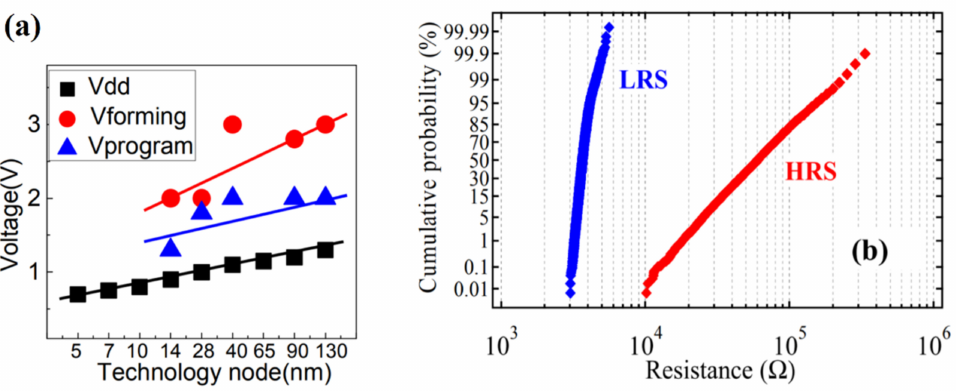
Figure 1. ( a ) The operation voltage of core device and RRAM cell at different technology nodes [45]. ( b ) The resistance distributions